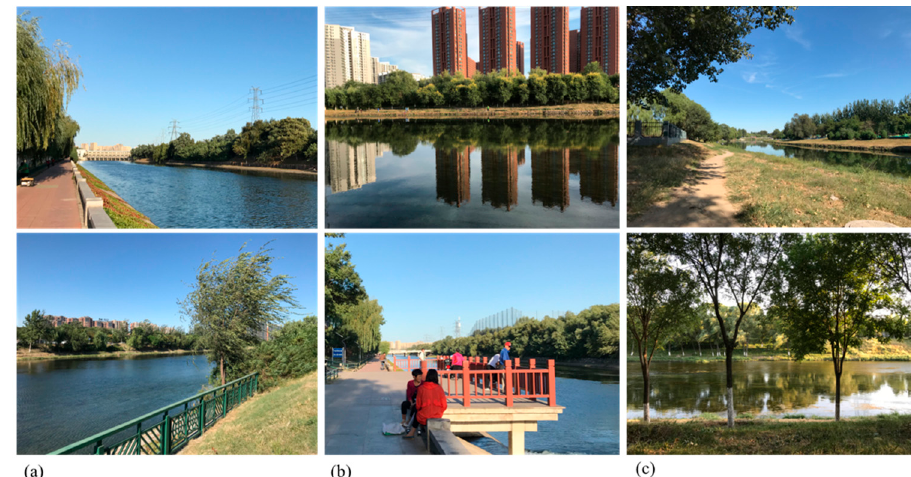
Figure 1. The location and the catchment of the Tsing River. Land covers were interpreted from Gaofen-2 remote sensing image.